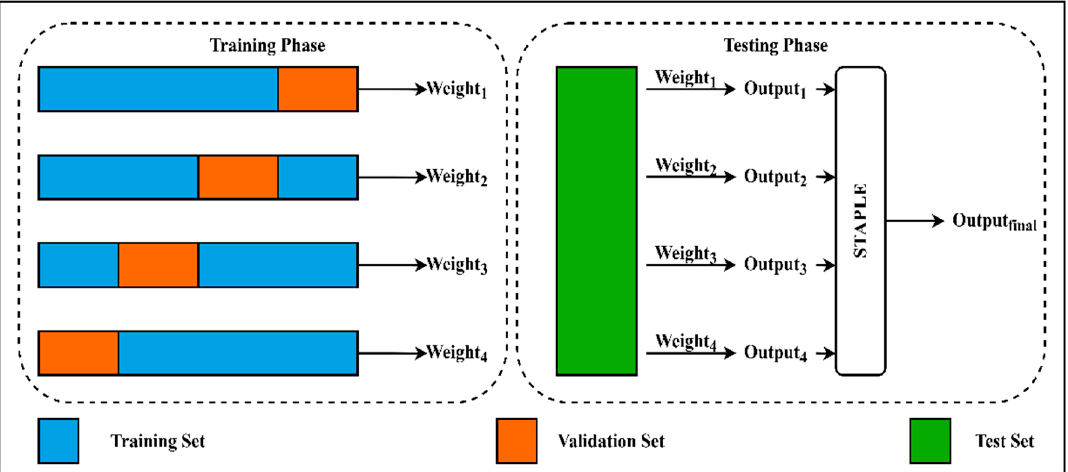
Figure 3. The overall architecture of our method.